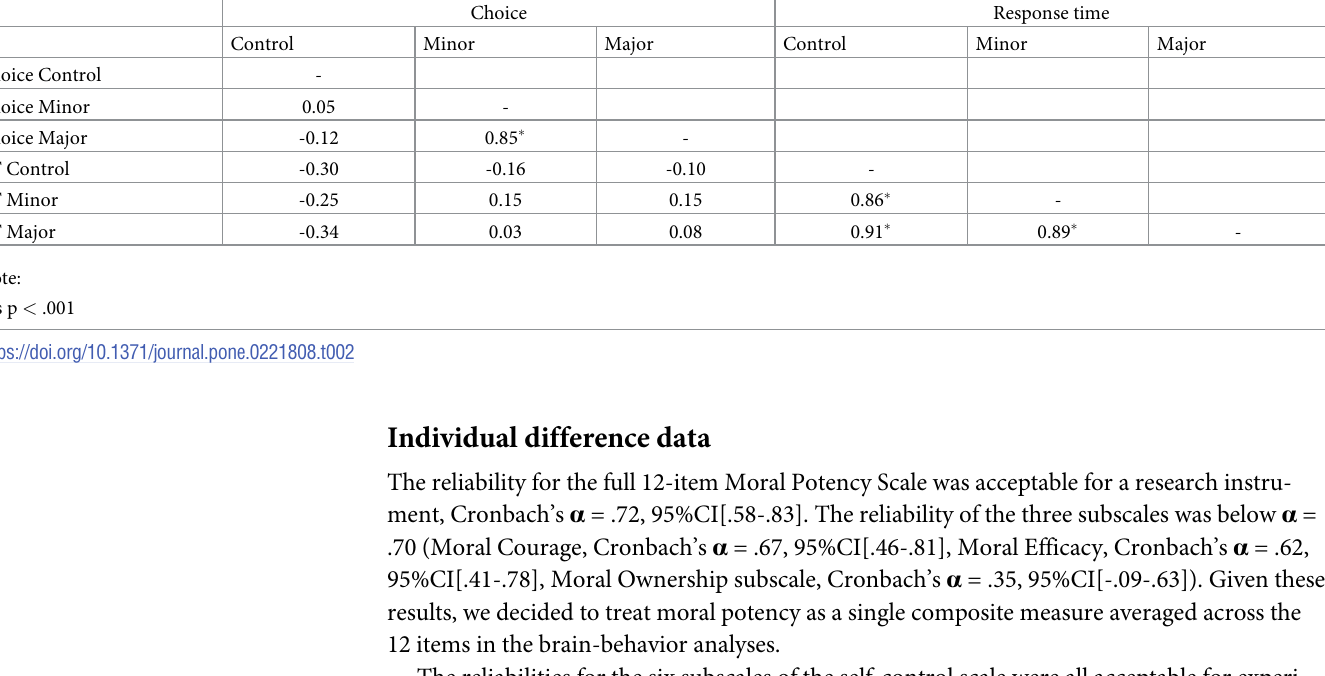
The reliability for the full 12-item Moral Potency Scale was acceptable for a research instru- ment, Cronbach’s α = .72, 95%CI[.58-.83]. The reliability of the three subscales was below α =